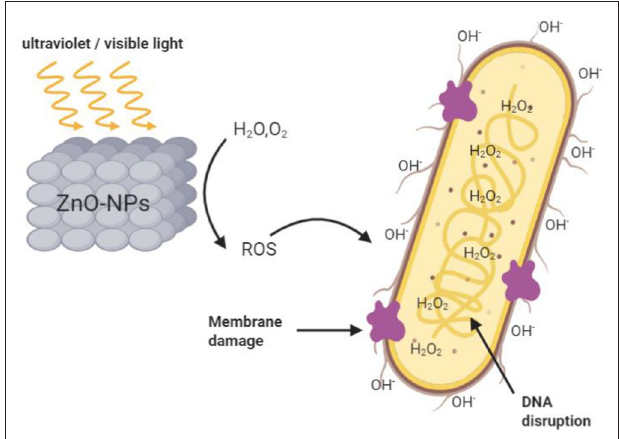
FIGURE 1 | Mechanism of ROS production from ZnO-NPs and their bactericidal effect.